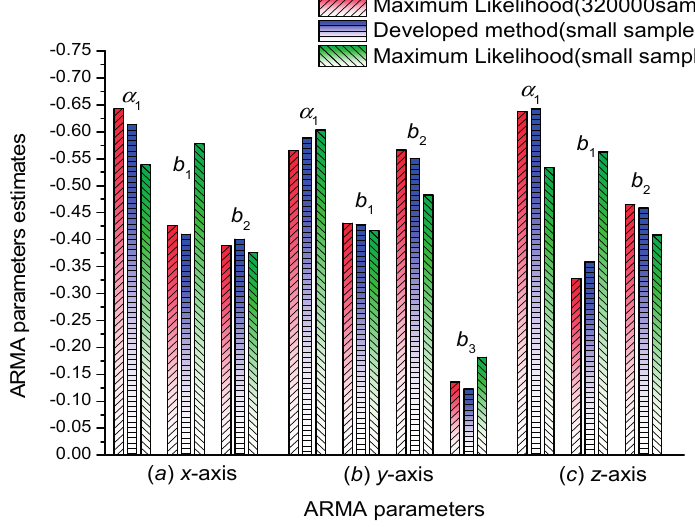
Figure 7. Comparison of ARMA modeling results using different